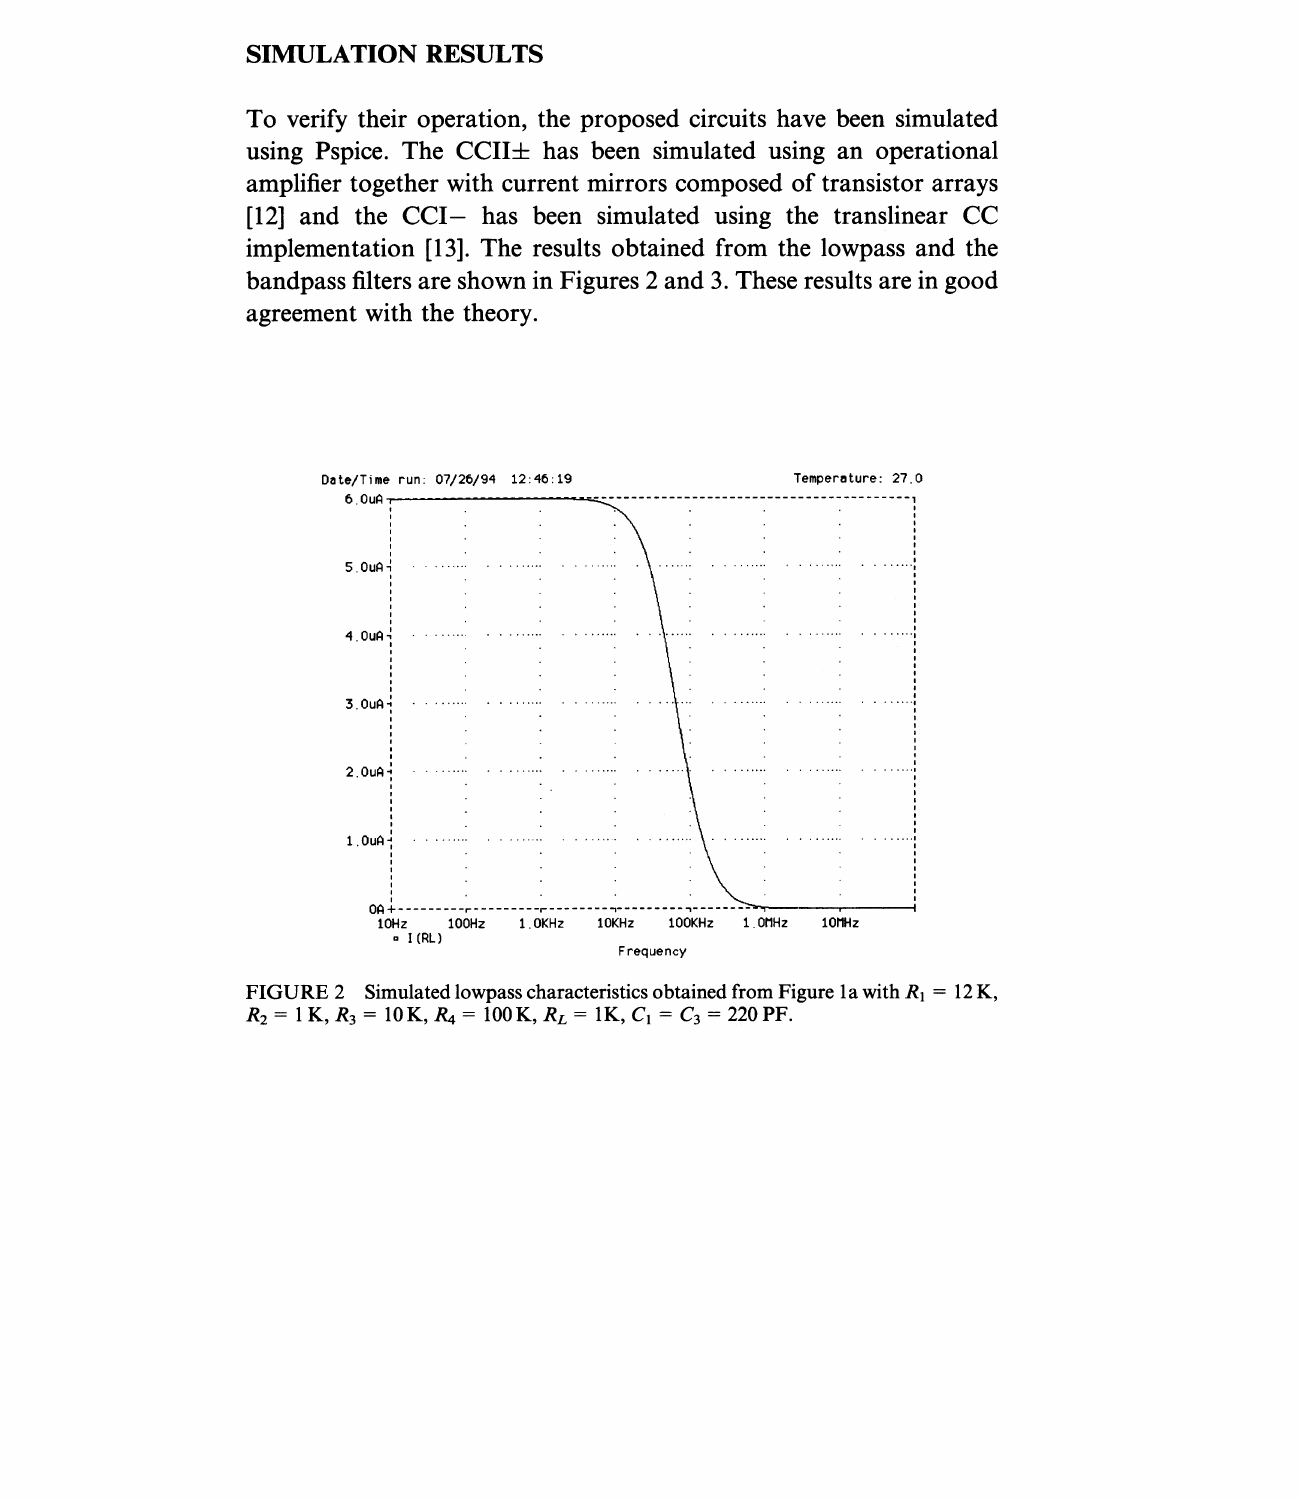
FIGURE 2 Simulated lowpass characteristics obtained from Figure la with R1 12 K,